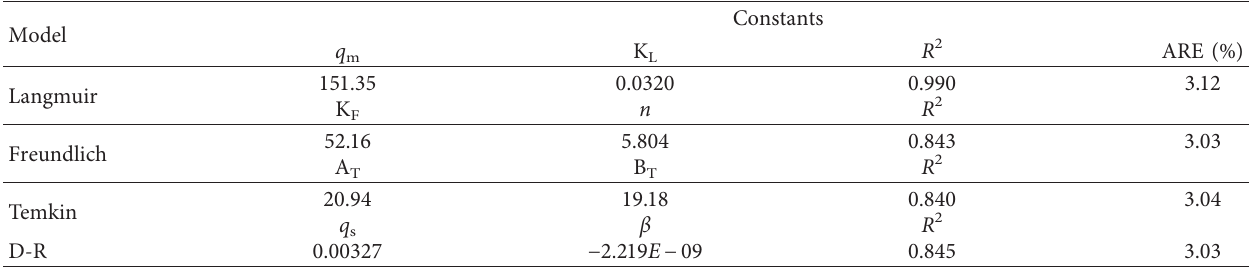
Table 4: Adsorption isotherm